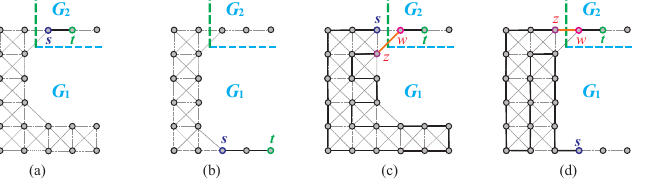
Figure 24. The longest ( s , t ) -path under that a (cid:62) 2 and c = 1, where ( a , b ) (UB5) holds and ( c , d ) (UB6) holds, where the bold lines indicate the constructed longest ( s , t )